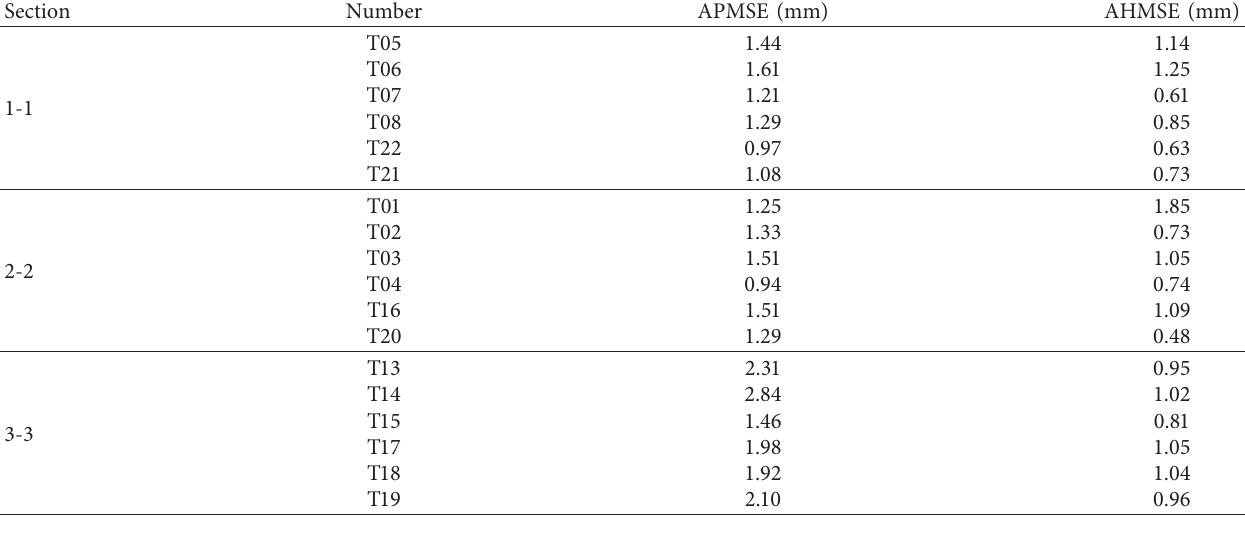
Table 1: Statistical results of AMSE in the slope monitoring